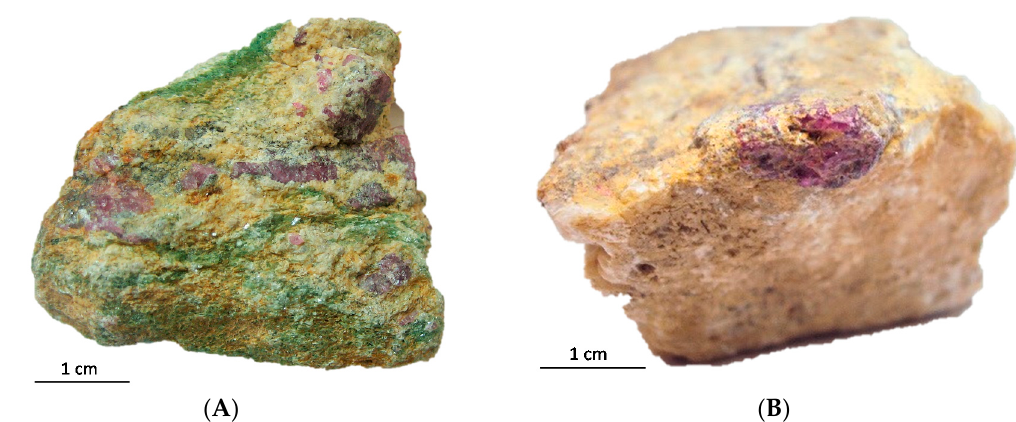
Figure 4. Images of hand specimens of Snezhnoe ruby-bearing rocks with: ( A ) ruby + plagioclase (albite–andesine) + muscovite (variety fuchsite) mineral paragenesis; ( B ) ruby + calcite mineral paragenesis. The images were modified from [11].